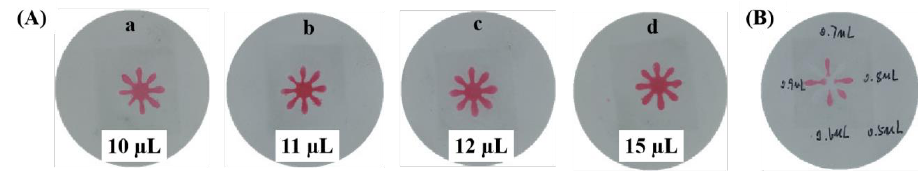
Figure 4. The optimization of the volume added in the central zone ( A ) and the detection zone ( B ).